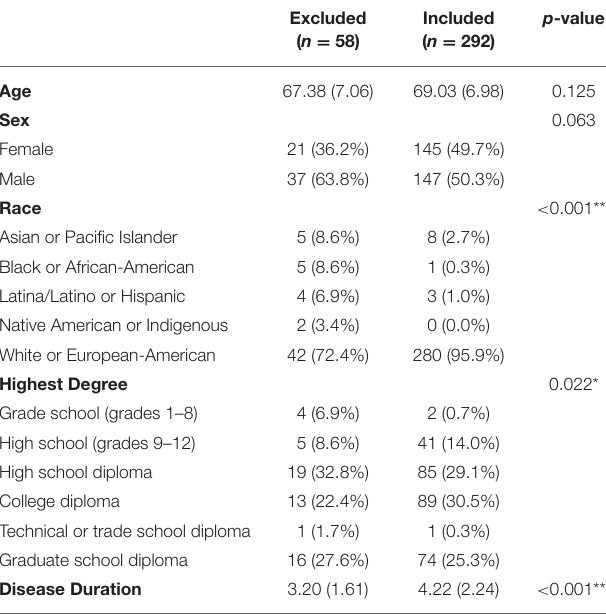
TABLE 1 | Mean (standard deviation) and count (%) for demographic variables of included and excluded PSP cases.